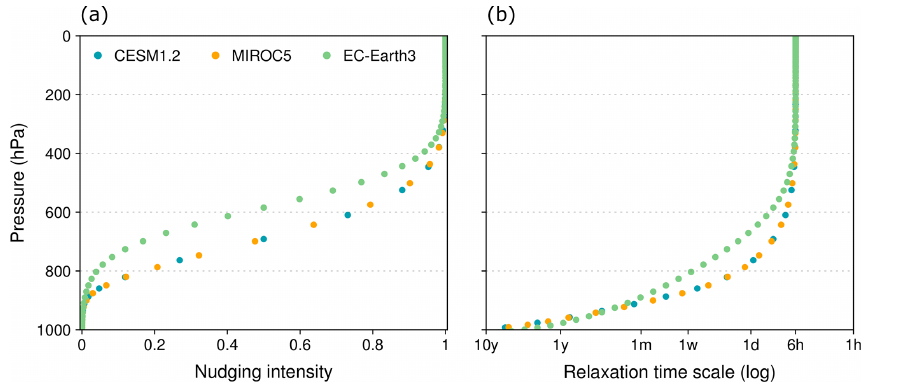
Figure 1. Nudging profile for the three ExtremeX ESMs. The height-dependent nudging intensity ( K ( z ), a ) and resulting relaxation timescale from the division by τ (b) are marked with dots for each model. The nudging intensity is given from zero (no nudging) to 1 (fully